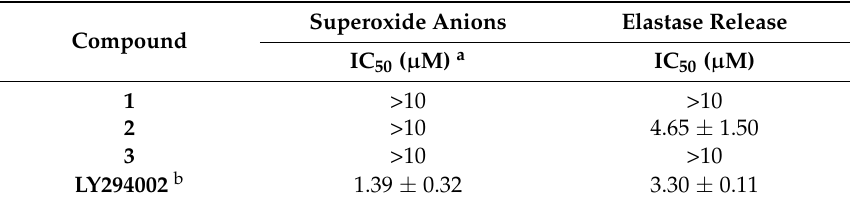
Table 4. Inhibitory effects of briaranes 1 – 3 on superoxide anion generation and elastase release by